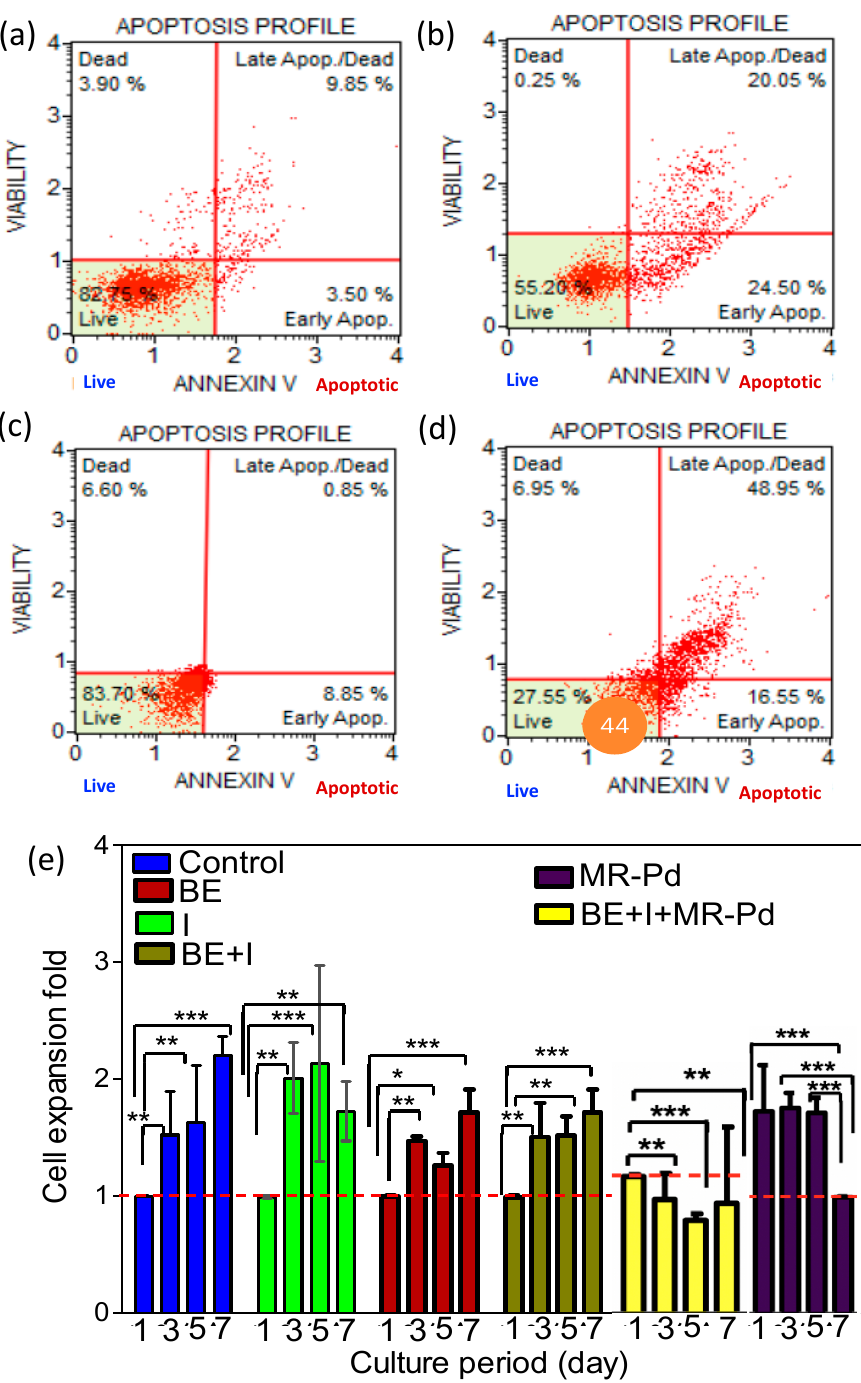
Figure 3. In situ drug synthesis for encapsulated PC-3 cells: ( a , b ) Flow Cytometry cell viability results on cncapsulated PC-3 cells in GelMA-Alginate without catalyst (7%:1% w / v ) ( c , d ) Flow Cytometry cell viability results on cncapsulated PC-3 cells GelMA-Alginate with MR-Pd catalyst (7%:1%:0.1% w / v ) ( e ) Cell proliferation based on presto blue assay. Encapsulated PC-3 cells in GelMA-Alginate in various combinations. [BE = Boronic Ester, I = Iodoprazole, MR-Pd = Mesoporous Catalyst]. Statstical